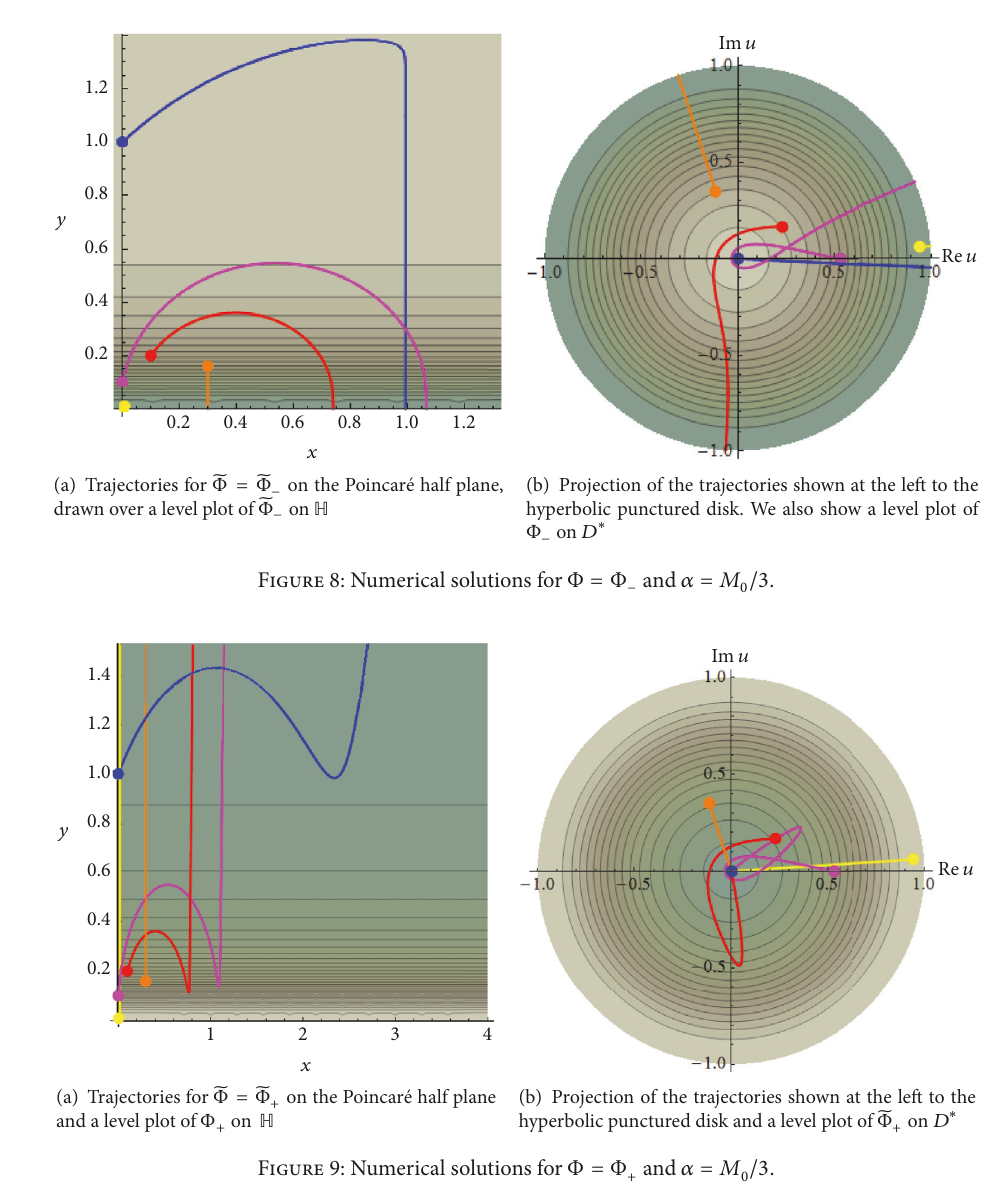
Figure 9: Numerical solutions for Φ = Φ + and 𝛼 = 𝑀 0 /3